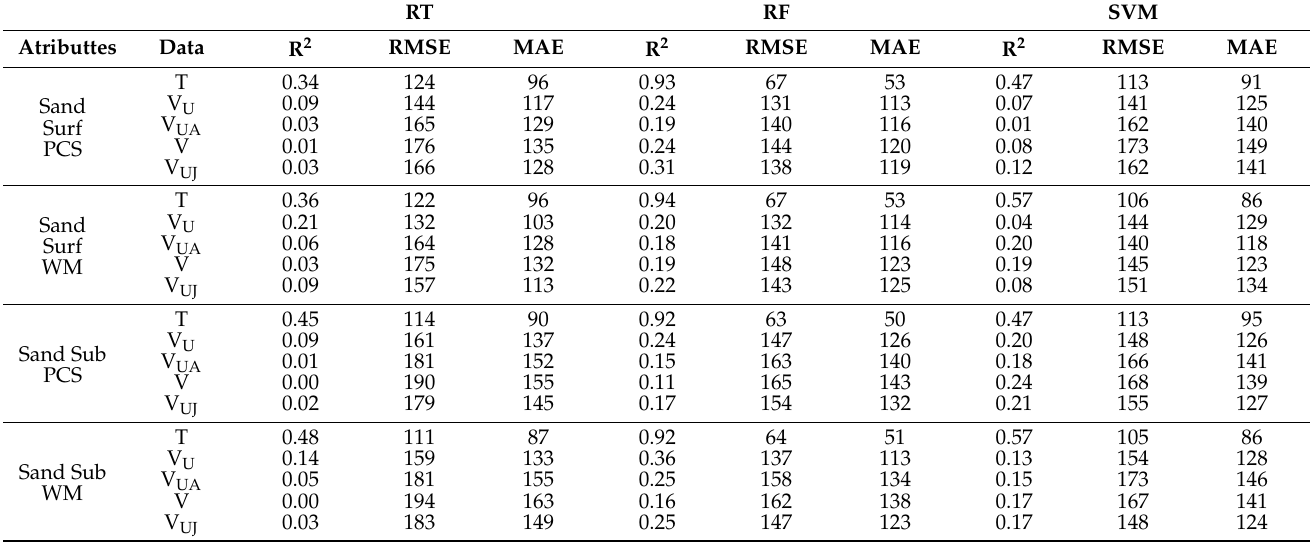
Table 5. Accuracy assessment soil surface and subsurface sand content predictions using the Refer- ence Area (RA) sampling